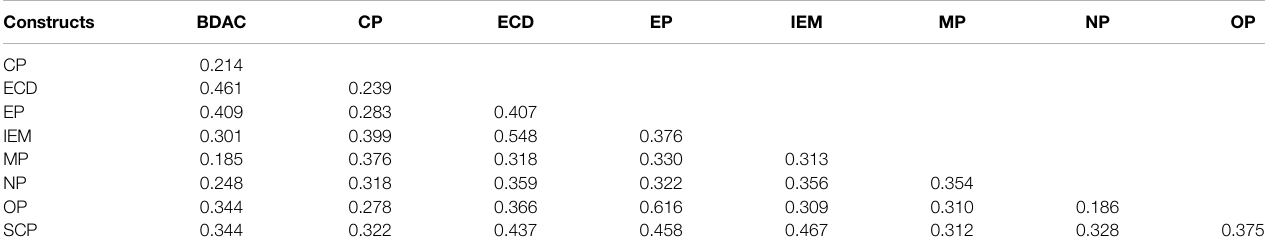
TABLE 5 | HTMT ratio.